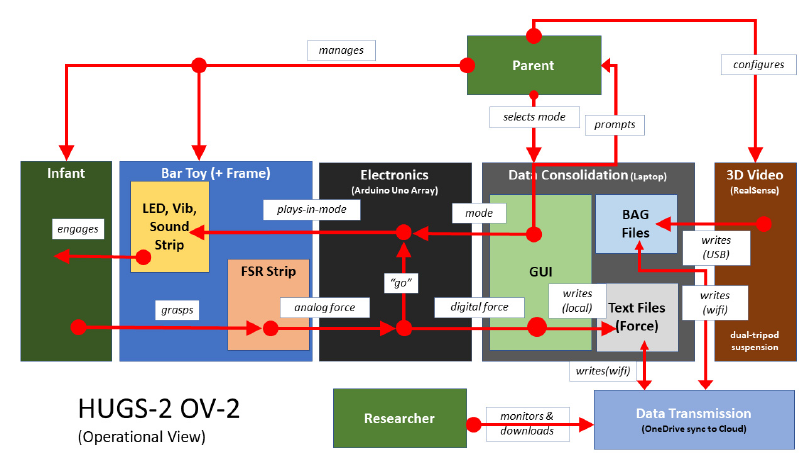
Figure 8. HUGS ‐ 2 system components and interoperation. Figure 8. HUGS-2 system components and